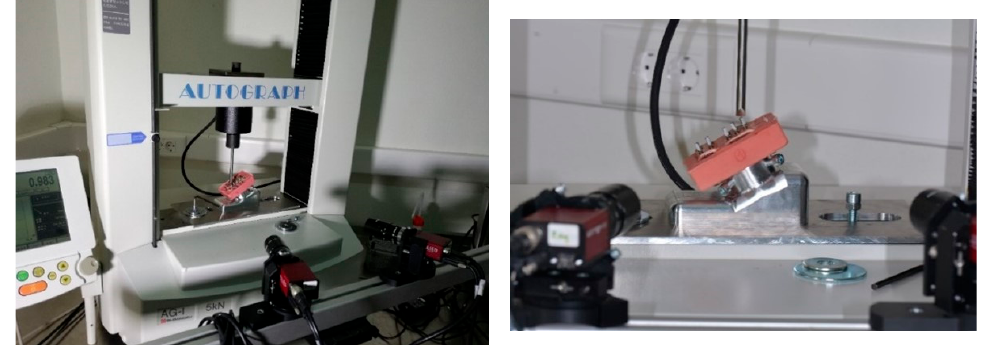
Figure 5. Configuration of the experiment in an electromechanical test machine that applied loads from 20 N to 200 N and the two high-resolution cameras that determined the micromovements.